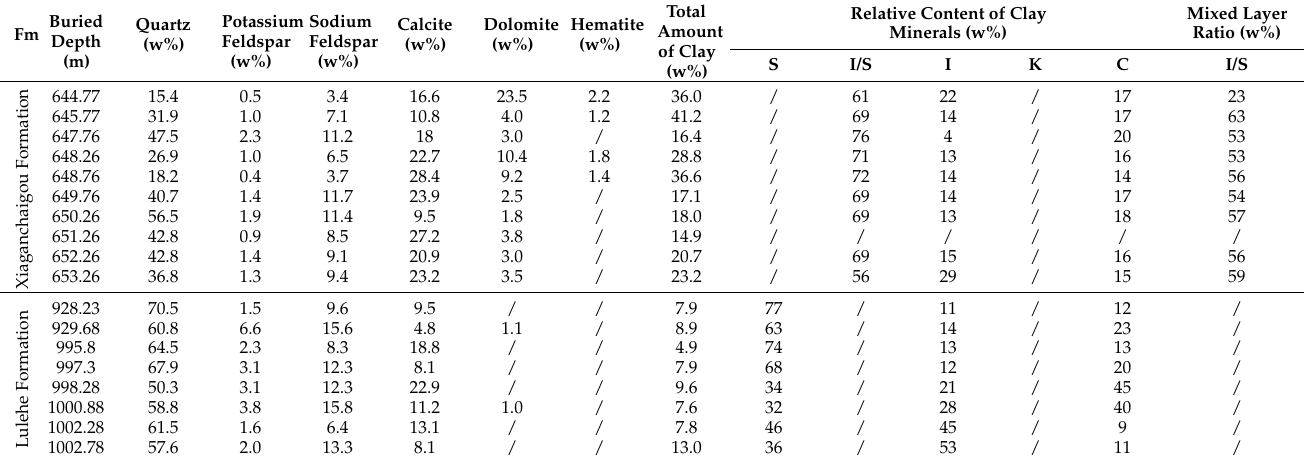
Table 1. X-ray diffraction analysis results of all Eocene rock and clay minerals in the Pingtai